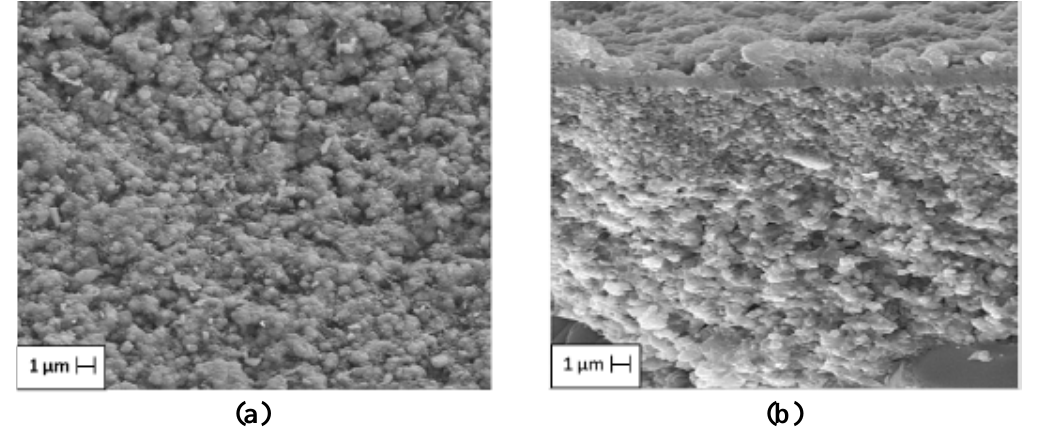
/Al O = 90) showing the 2 2 3